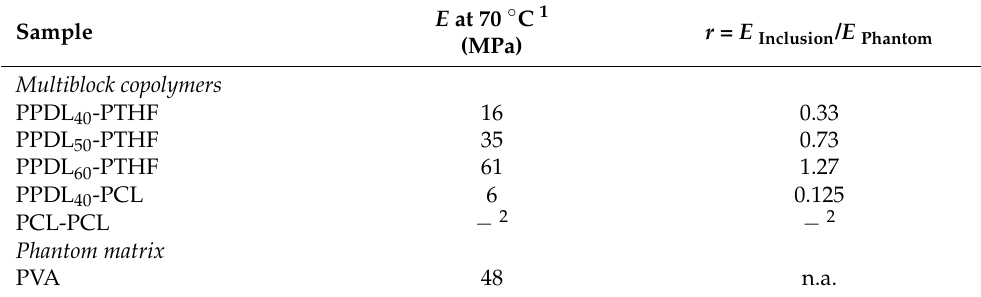
Table 1. Structure and properties of investigated polymers.